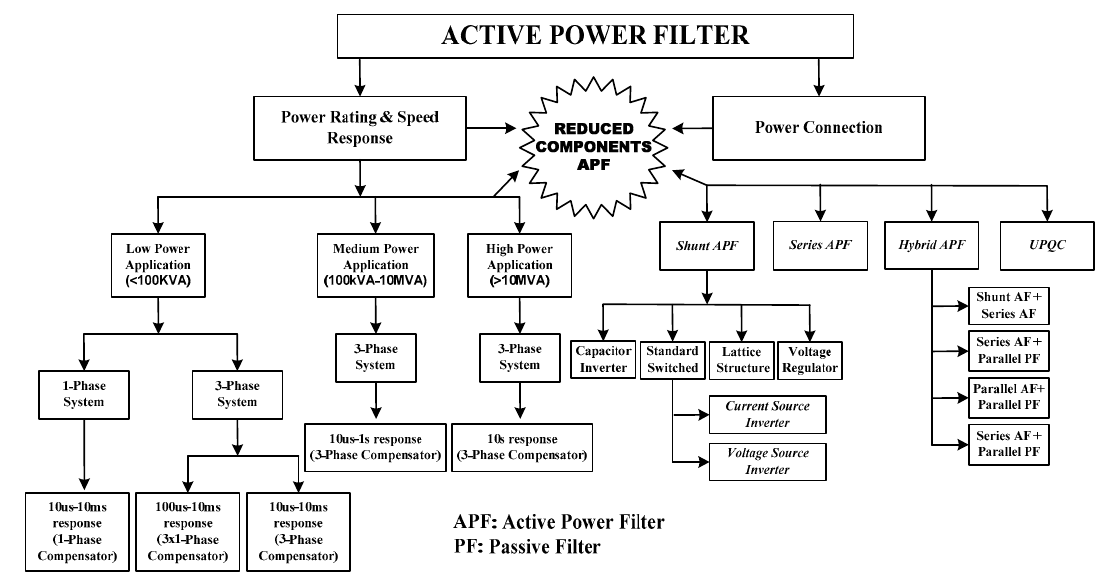
Figure 5. Hierarchical structure of APF classifications.